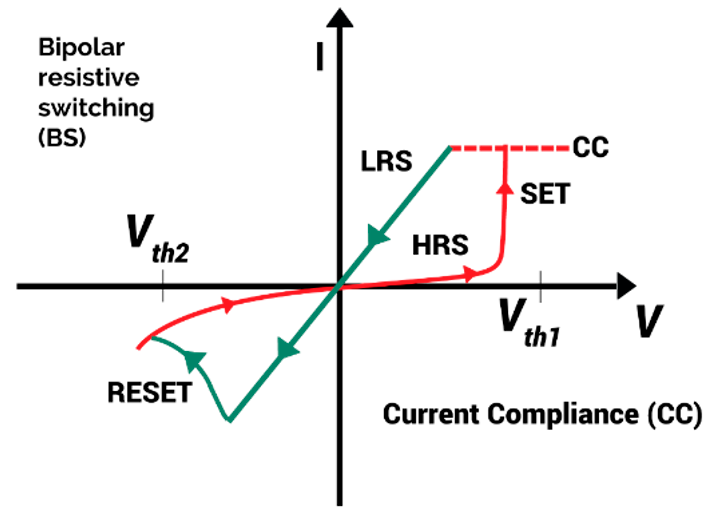
Figure 3. Typical I-V plot for the bipolar switching trends in a resistive switching memory device. The image here is adopted and modified from Reference [13], Copyright 2015, John Wiley & Sons.